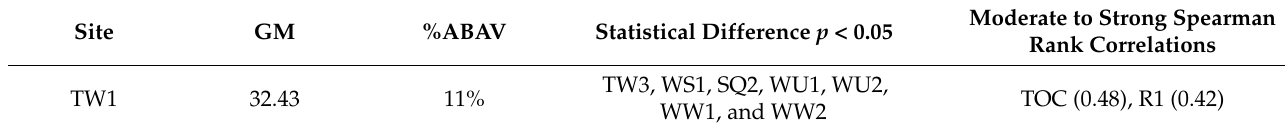
Table 4. Site-specific characterization: Enterococci ( n =